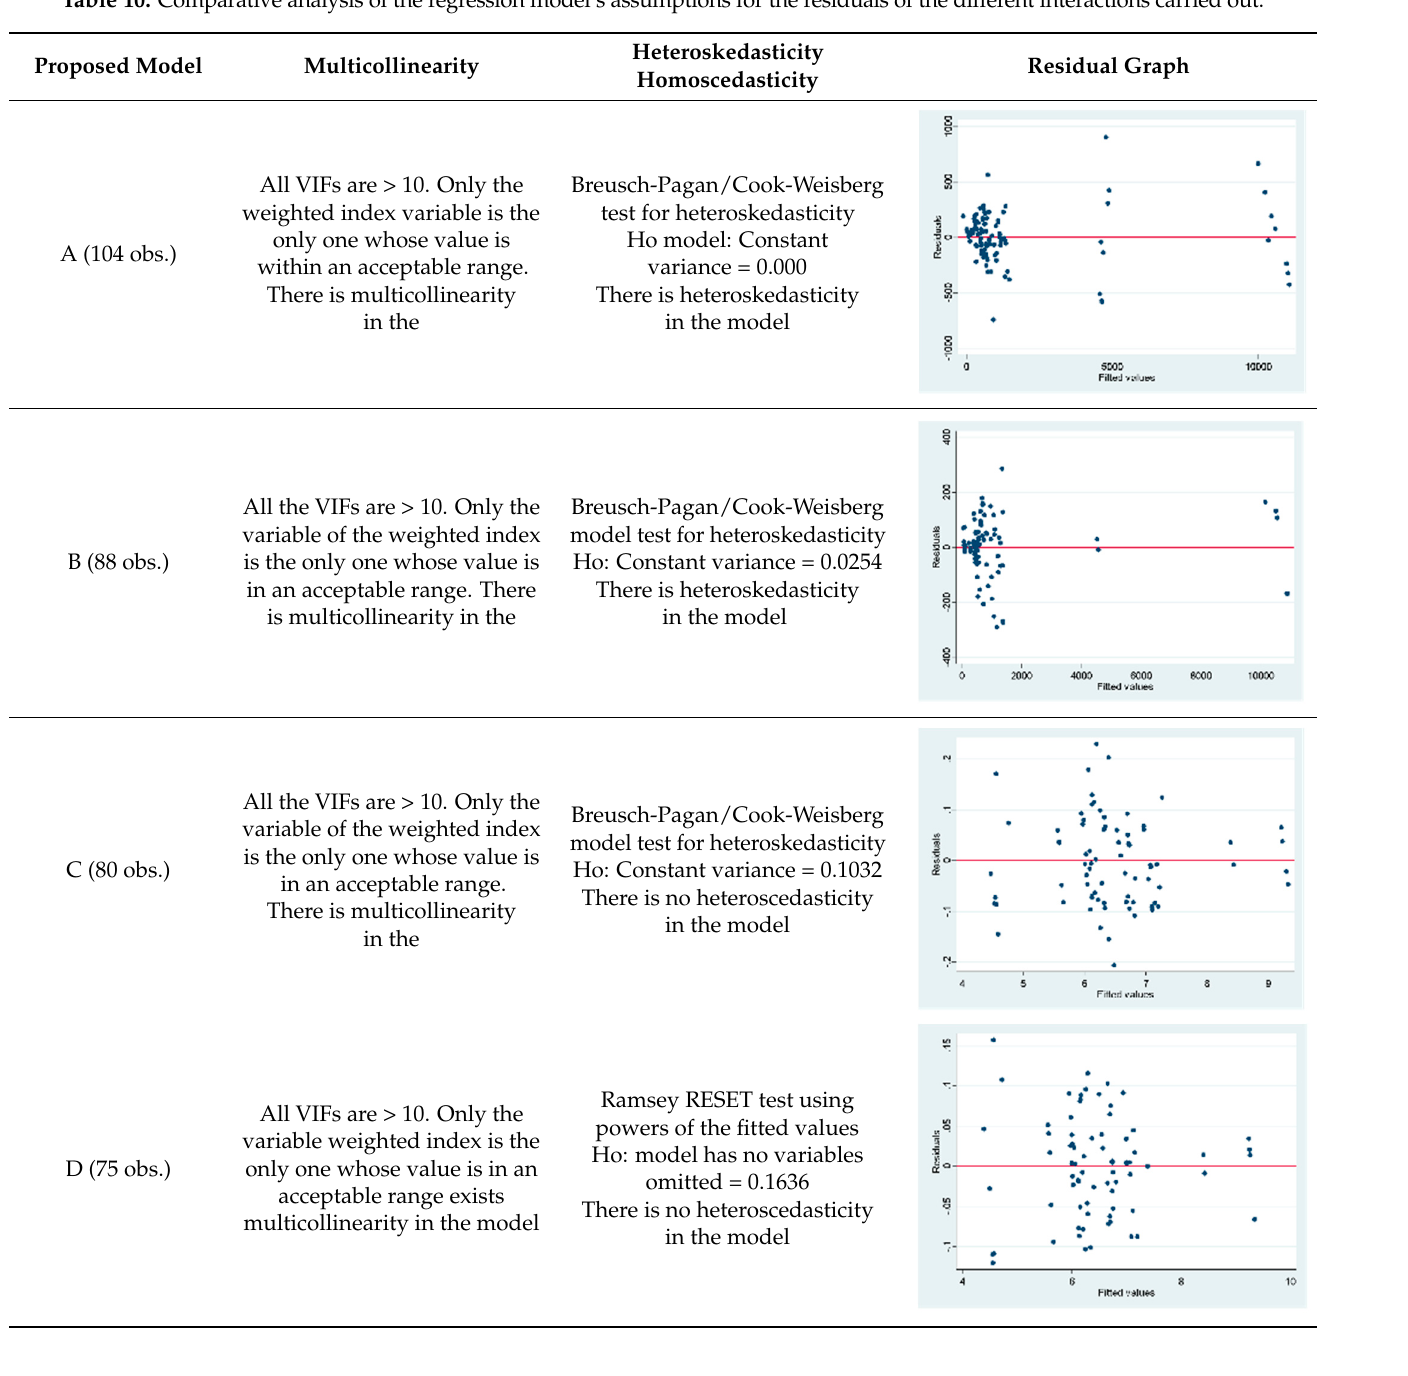
Table 10. Comparative analysis of the regression model’s assumptions for the residuals of the different interactions carried out.